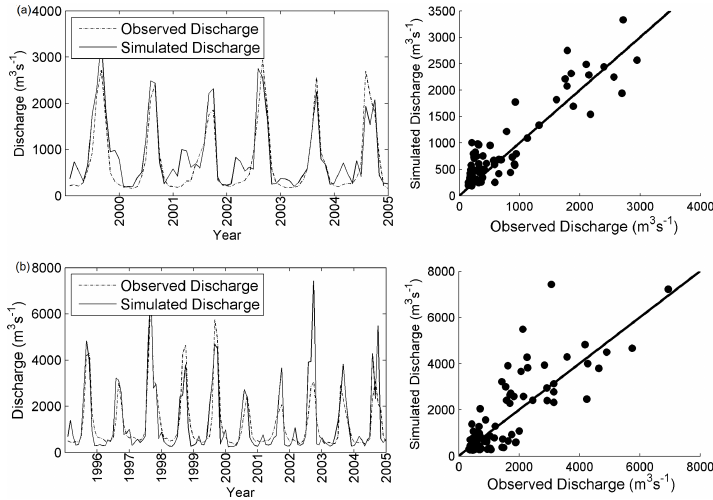
Figure 5. Validation results of (a) upstream and (b) midstream